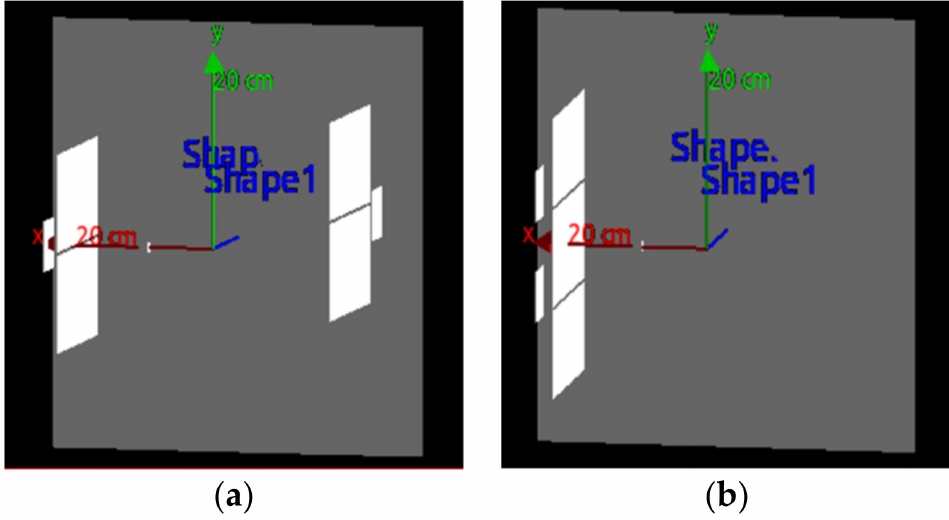
Figure 16. Geometric structures ( a , b ) of cone-beam collimation